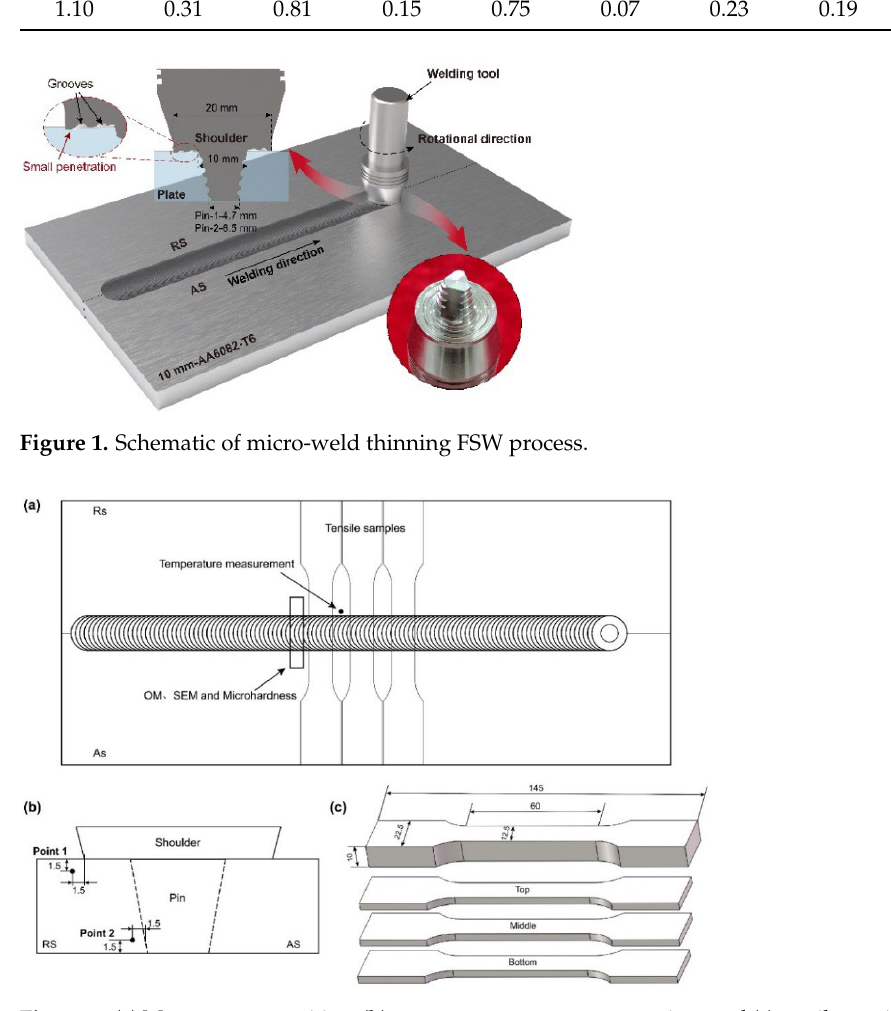
Figure 1. Schematic of micro-weld thinning FSW process. Table 1. Chemical compositions of AA6082-T6 ( wt% ).